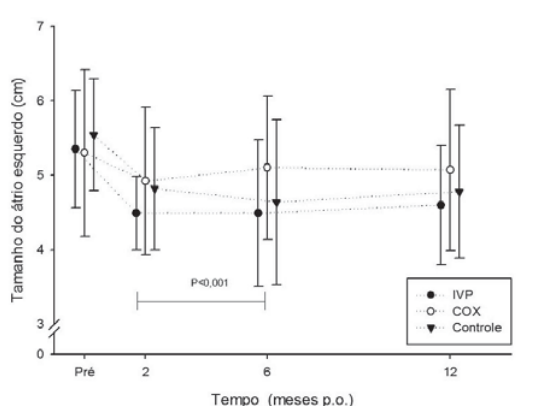
Fig. 1 - Resposta cronotrópica expressa em porcentual da freqüência cardíaca esperada, pelo tempo, por grupo; P=0,0012 para grupo Fig. 2 - Tamanho do átrio esquerdo pelo tempo, por grupo de